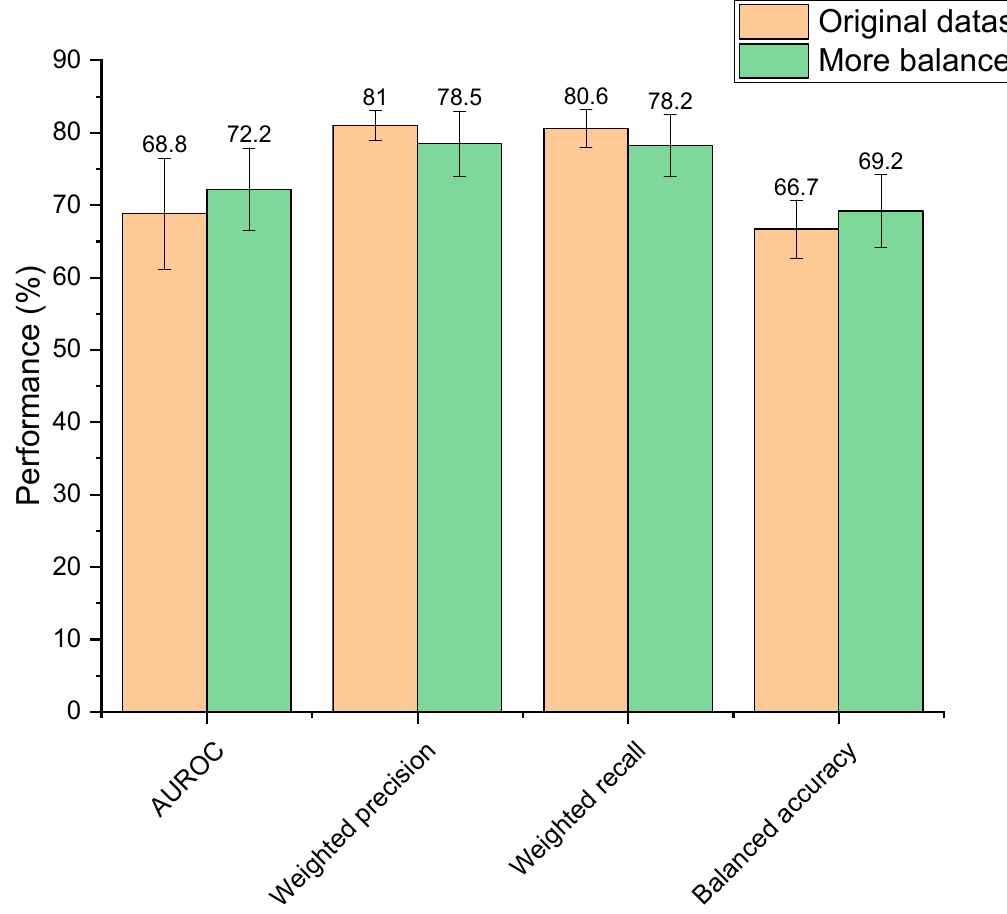
Figure 3. Performance of two extra trees machine learning models in predicting drugs’ microbial depletion status. Orange bars indicate scores for the model trained on the original unbalanced dataset. Green bars indicate scores for the model trained on a more balanced dataset.